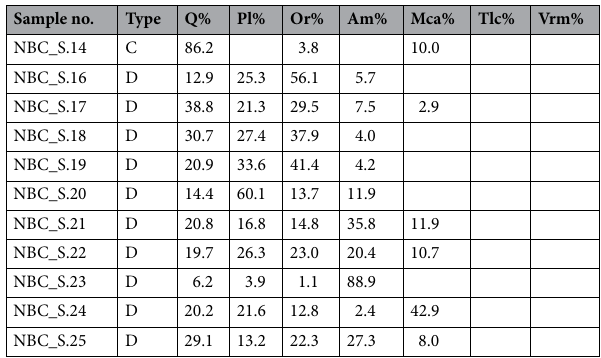
Table 1. RIR-XRD results of the major mineral phases of the samples from Mbanza Kongo (MBK), Kindoki (KDK) and Ngongo Mbata (NBC). Q quartz, Pl plagioclase, Or potassium feldspar, Am amphibole, Mca mica, Tlc talc, Vrm